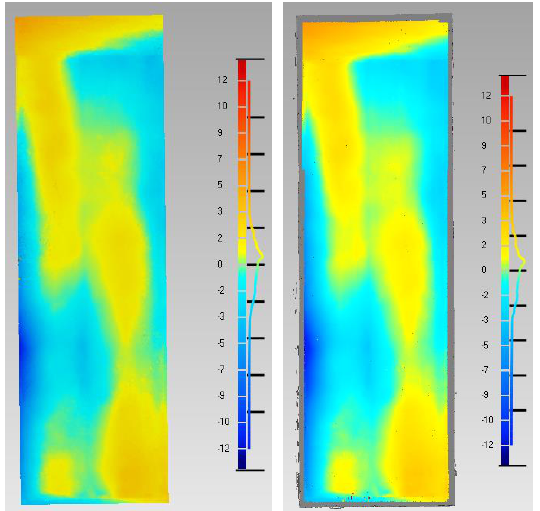
Figure 8. Deformation analysis on the Saint John the Baptist painting assuming a planar shape of the artwork. Photogrammetric 3D model (left) and structured light scanner 3D model